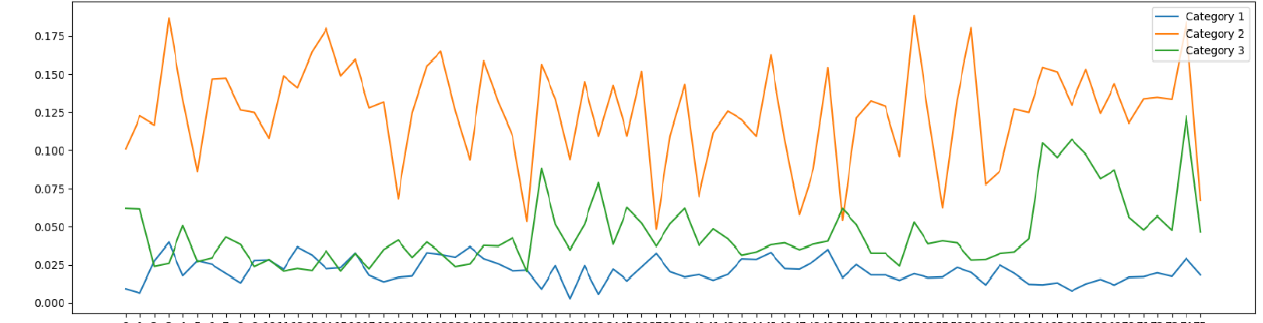
Figure A2. Centers of the cluster.